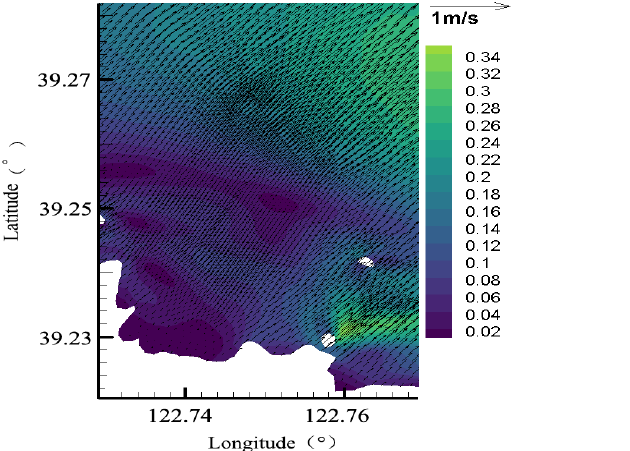
Figure 12. Residual current distribution in the sea area near the aquaculture area ( left : before aq- uaculture; right : after aquaculture).